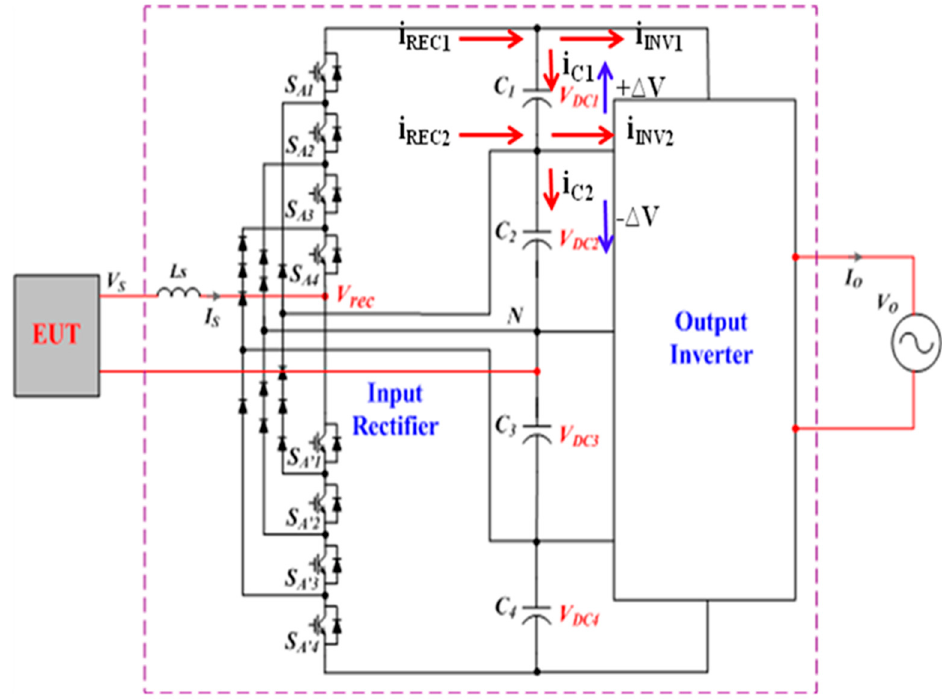
Figure 6. DC-link currents of the five-level OCC MV Regen-Load in region I and II.